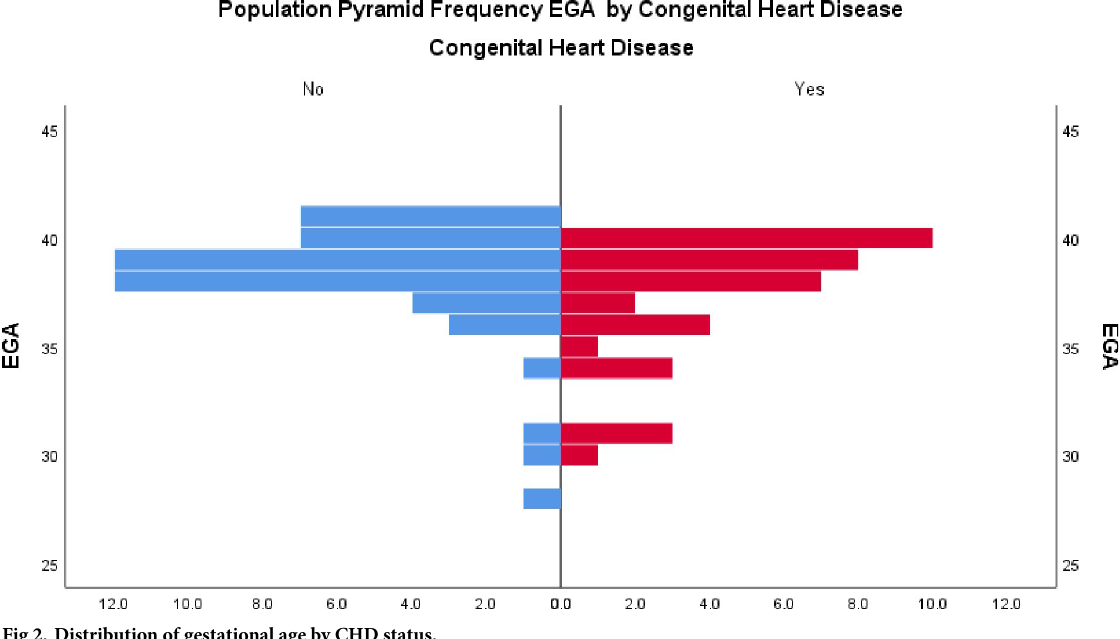
Fig 2. Distribution of gestational age by CHD